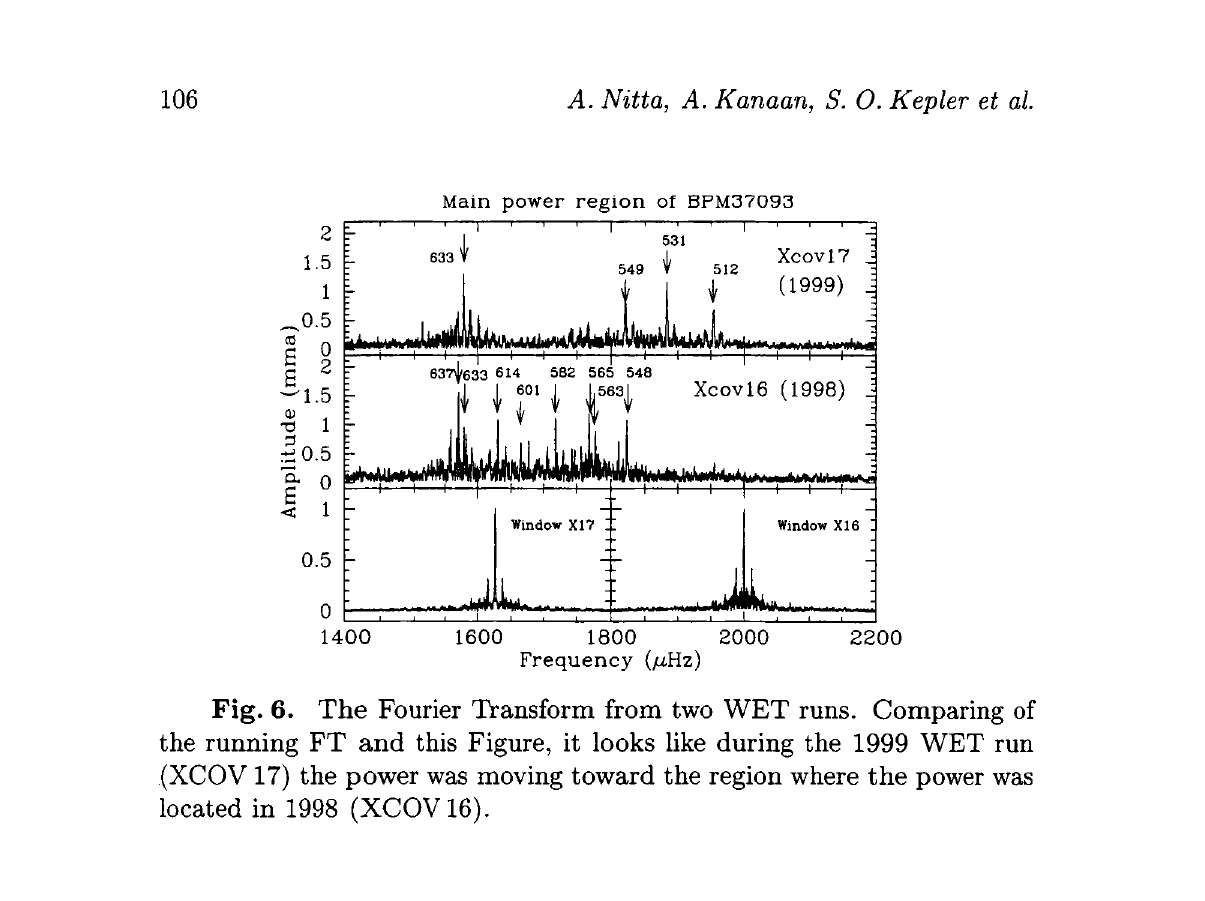
Fig. 6. The Fourier Transform from two WET runs. Comparing of the running FT and this Figure, it looks like during the 1999 WET run (XCOV17) the power was moving toward the region where the power was located in 1998 (XCOV